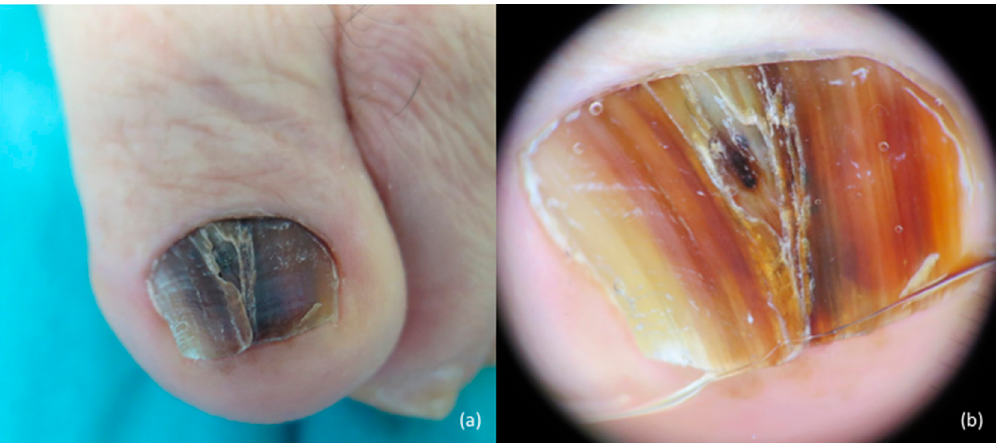
Figure 1. Nail melanoma of the great toenail clinically presenting as a longitudinal melanonychia ( a ). At onychoscopy, ( b ) heterogeneous irregular longitudinal bands of pigment with nail plate dystrophy; pigmentation extends to the hyponych- ium (Hutchinson’s sign).